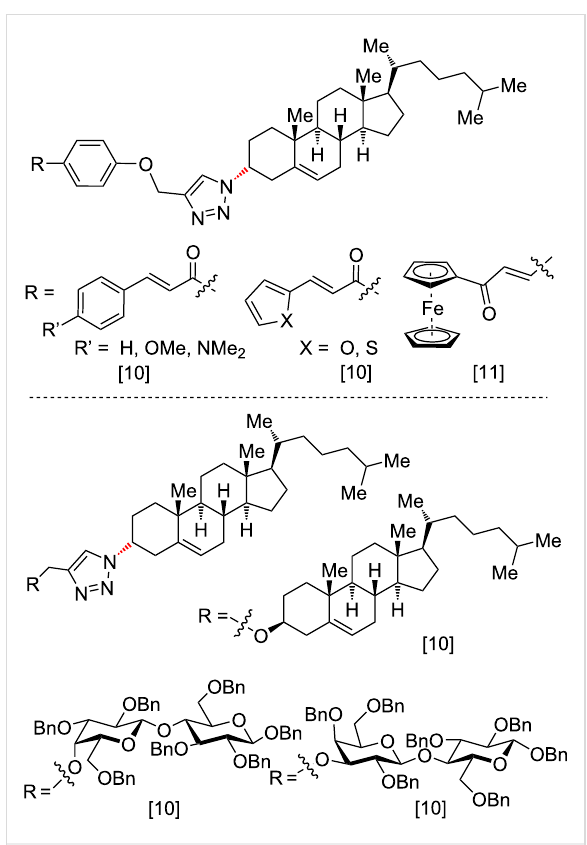
Figure 6: Compounds (next to 4 , 5 and 9 ) to be corrected in refs. [10] and [11]. The respective bonds are highlighted in